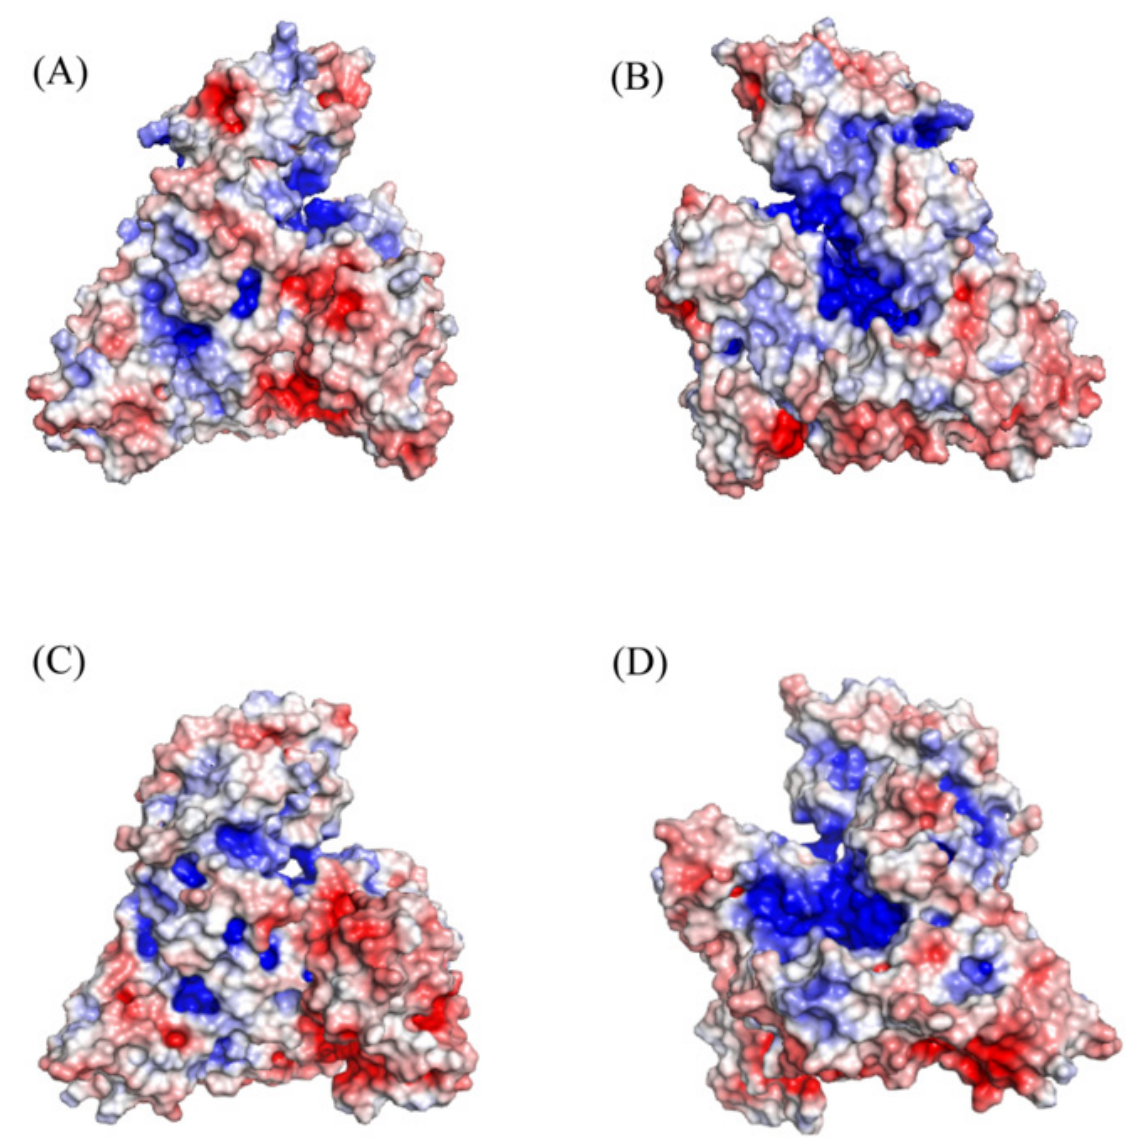
Figure 2. A comparison of surface charge distribution between HSA ( A , B ) and BSA ( C , D ). The two views for each protein structure are flipped 180 ° along the vertical axis. The images were generated by PyMOL using 1AO6 and 4F5S PDB files.